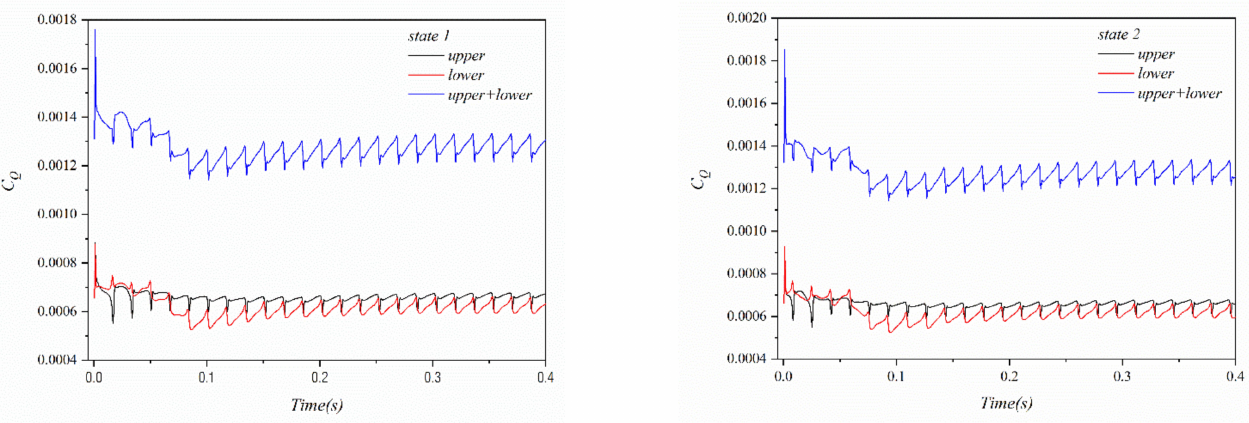
Figure 11. The isolated rotor C Q of the upper and lower rotors in